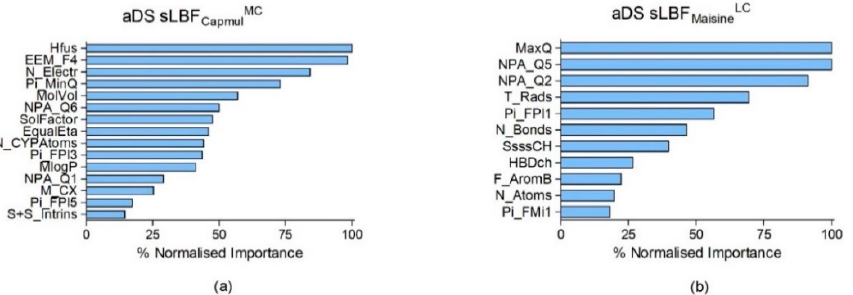
Figure 4. Normalised importance charts of the ANNs for sLBF CapmulMC ( a ) and sLBF MaisineLC ( b ) detailing the percentage importance of the input variables in predicting aDS. Details and explained abbreviations are given in the main text and Supplementary Materials (Figure S1).